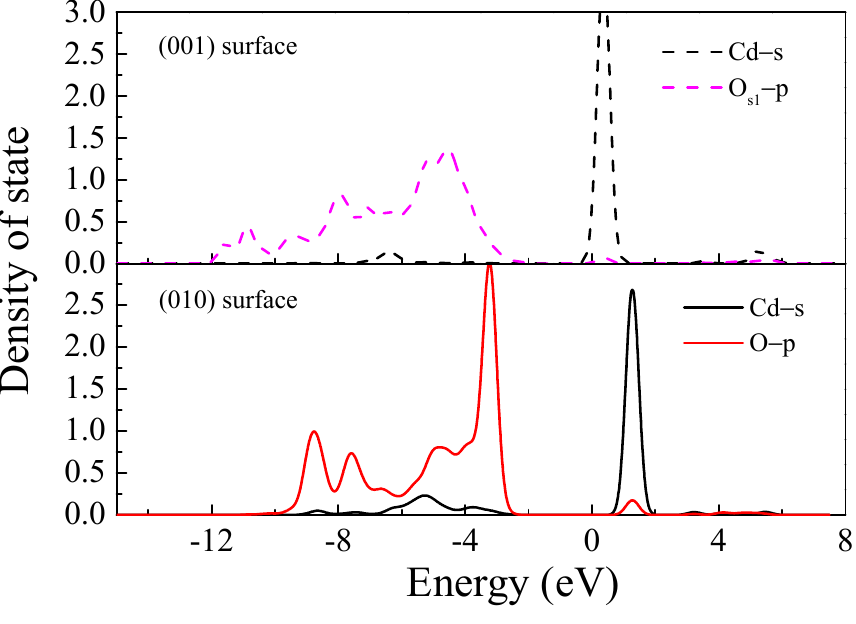
Figure 5. State density between Cd and O s1 .